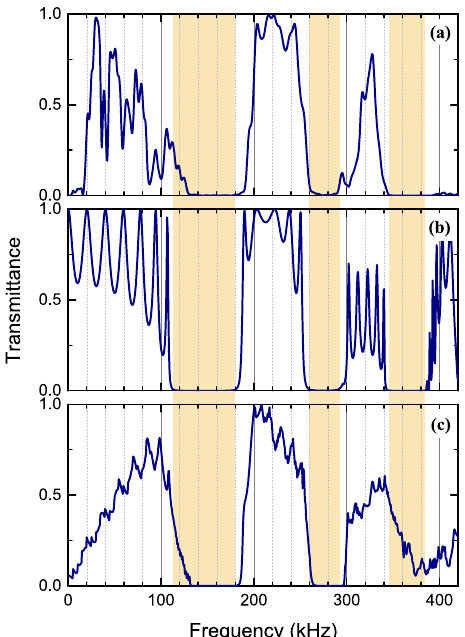
Figure 2. ( a ) measured transmittance of an acoustic beam incident on the seven-(001)-layers thick slab of the 3D sc crystal immersed in water; ( b ) calculated transmittance of a longitudinal plane wave incident normally ( k (cid:107) = 0 ) on the structure; and ( c ) normalized sum of the calculated transmittances ( q ,0 ) components, with q varying from 0 to 2 over several k (cid:107) = π a regions show gap positions for ( b ) to guide the eye.